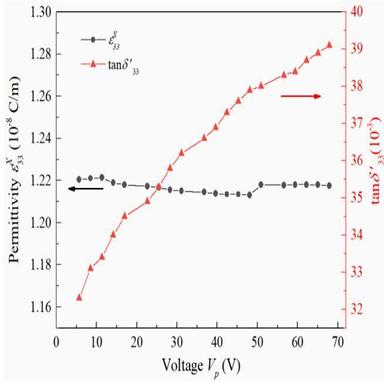
The dielectric constant εX 33 and dielectric loss tanδ ʹ 33 of the PMN-PT composite as a function of the AC driving voltage.